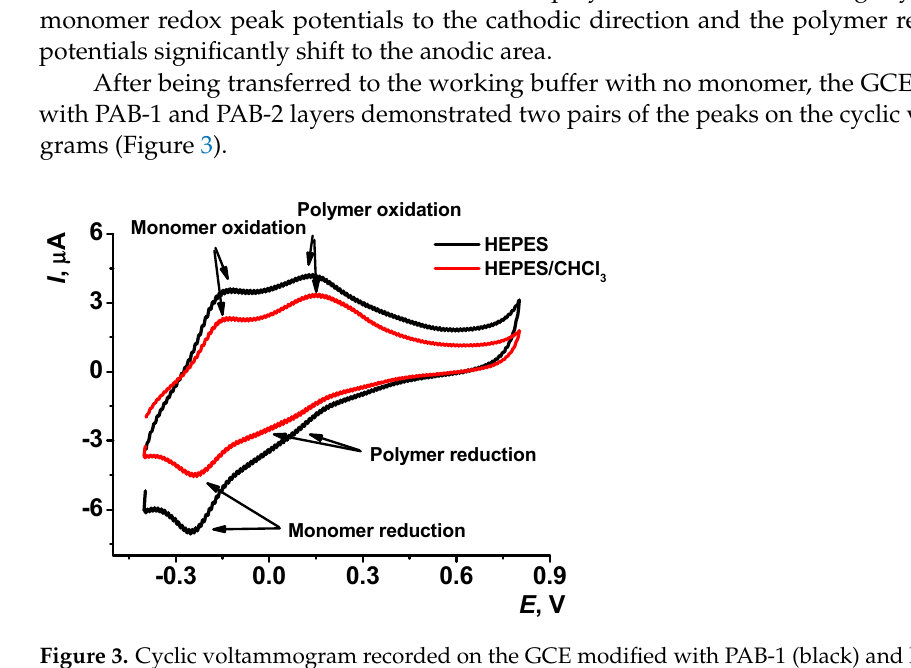
Figure 3. Cyclic voltammogram recorded on the GCE modified with PAB-1 (black) and PAB-2 (red) in 0.1 M HEPES with 0.03 M NaCl, pH = 7.0, scan rate 100 mV/s. Peak currents in the presence of chloroform are lower compared to those in the water medium. Previously, in the literature, it has been shown that Azure B monomer can be entrapped into the poly(Azure B) film [4]. Poly(Azure B) redox signal stability was tested on six electrodes modified with the same method. After 10 consecutive voltammogram registration, the polymeric form provided a more stable signal compared to the monomeric form. For example, changes in PAB-2 polymer reduction signal were about 1 %, whereas monomer reduction signal reduced twice. This could be explained by leaching of the monomer from the surface layer. The magnitude and ratio between two described pairs of redox peaks for PAB-1 and PAB-2 was strictly influenced by the pH value (Figure 4).